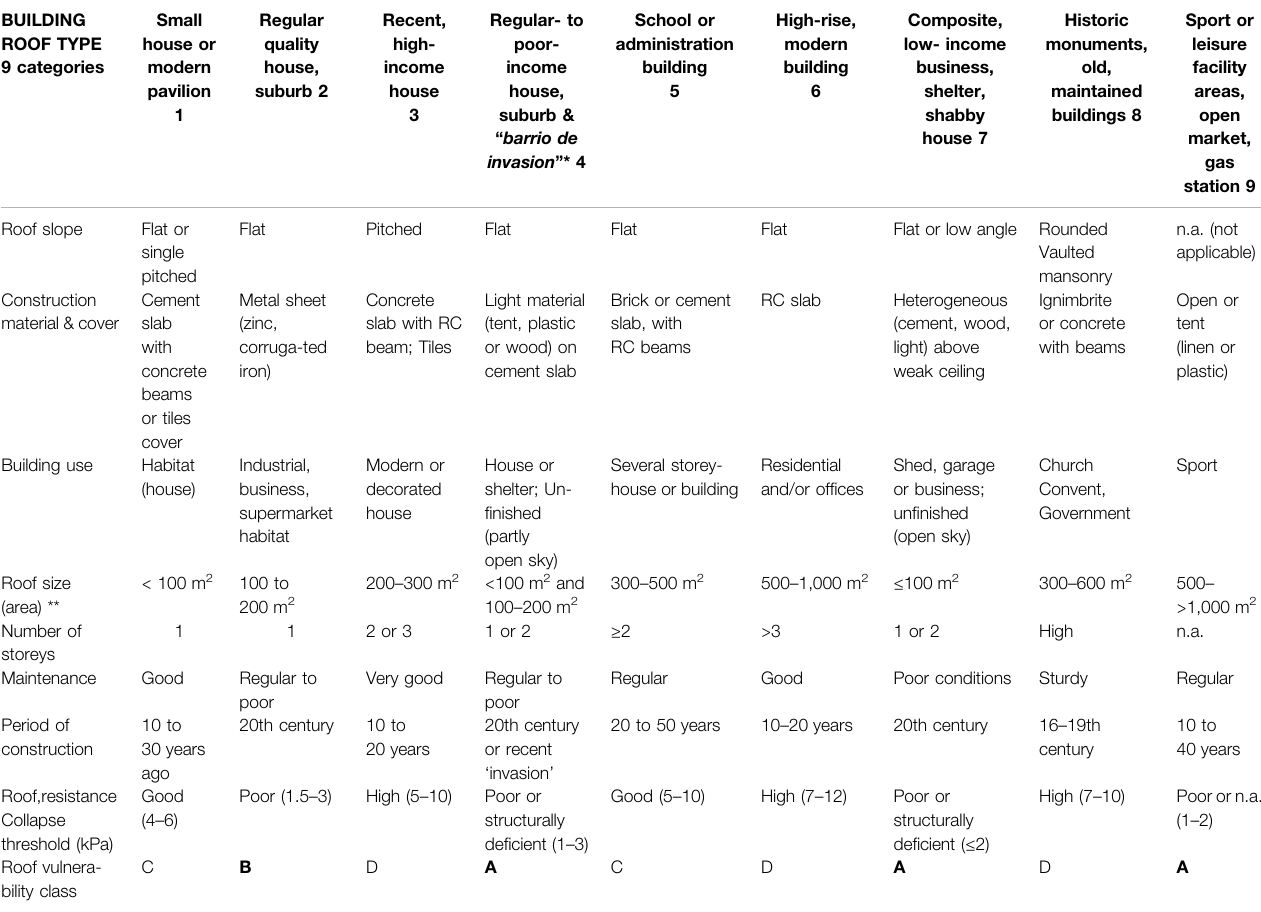
TABLE 4| Building rooftypes and vulnerabilityclasses based oneight criteria. *Barrio deinvasion: “ illegal ” settlement,settlement without basicneeds giventonew migrants for a small amount of money or with the purpose to obtain electoral support or political in fl uence. **Size or area: small ( < 100 m 2 ), medium size (100 – 300 m 3 ), large size (300 – 1,000 m 2 ), very large size ( > 1,000 m 2